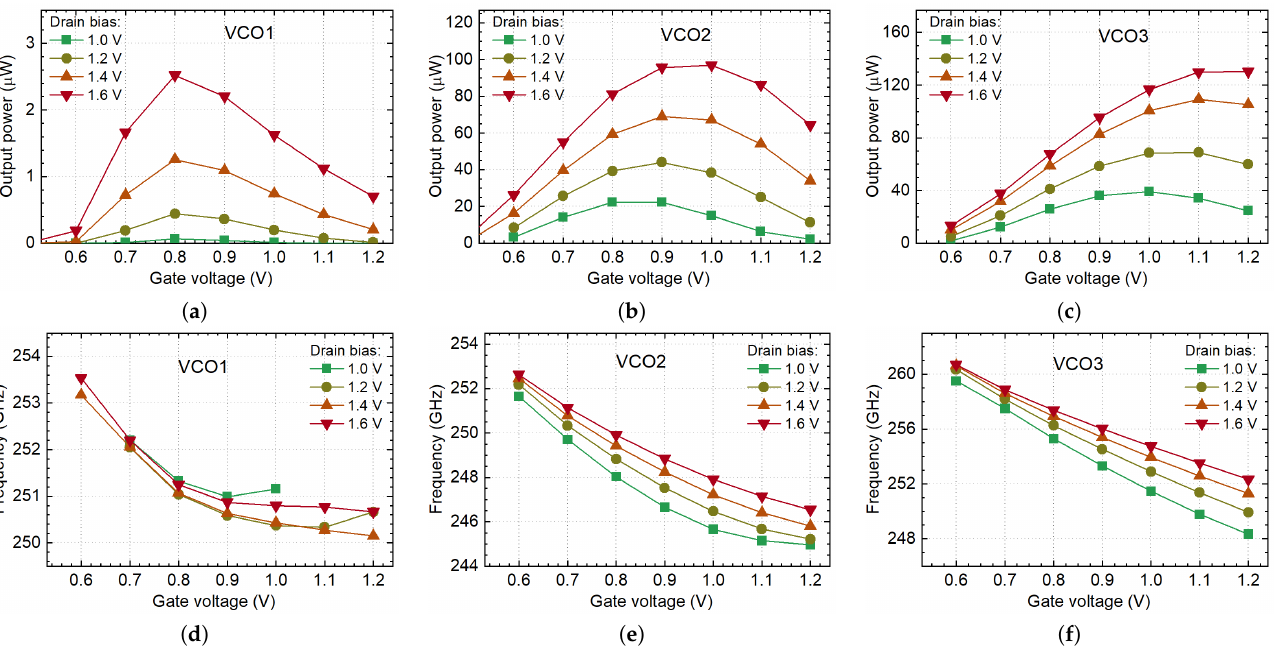
Figure 6. Simulations of third-harmonic output power (( a – c ) panels) and the frequency (( d – f ) panels) as a gate bias V g function for different drain voltages V d . The power is estimated including antenna radiation